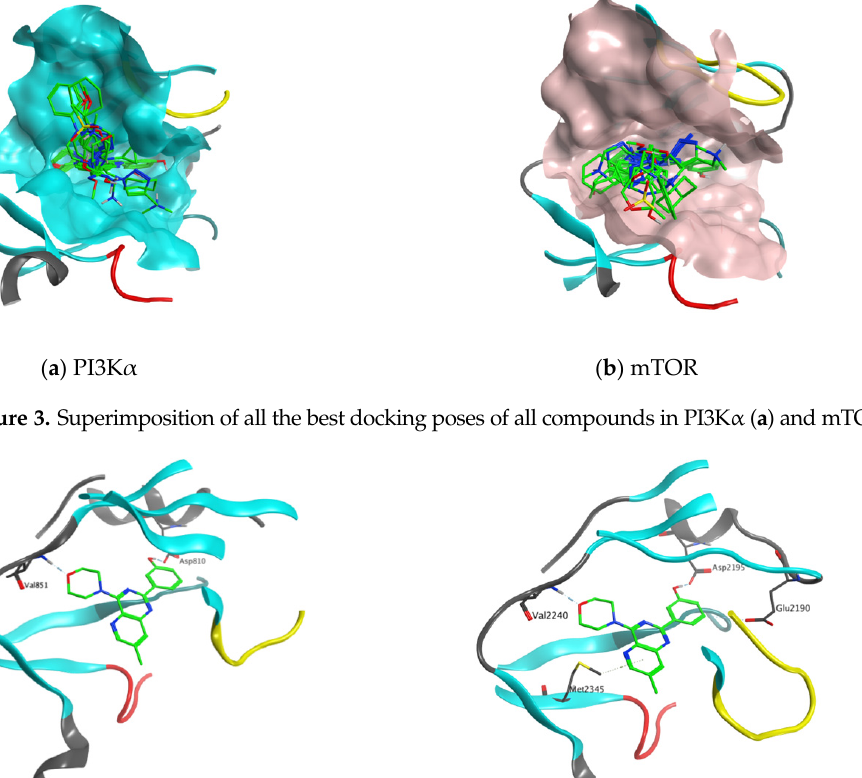
Figure 3. Superimposition of all the best docking poses of all compounds in PI3K α ( a ) and mTOR ( b ).